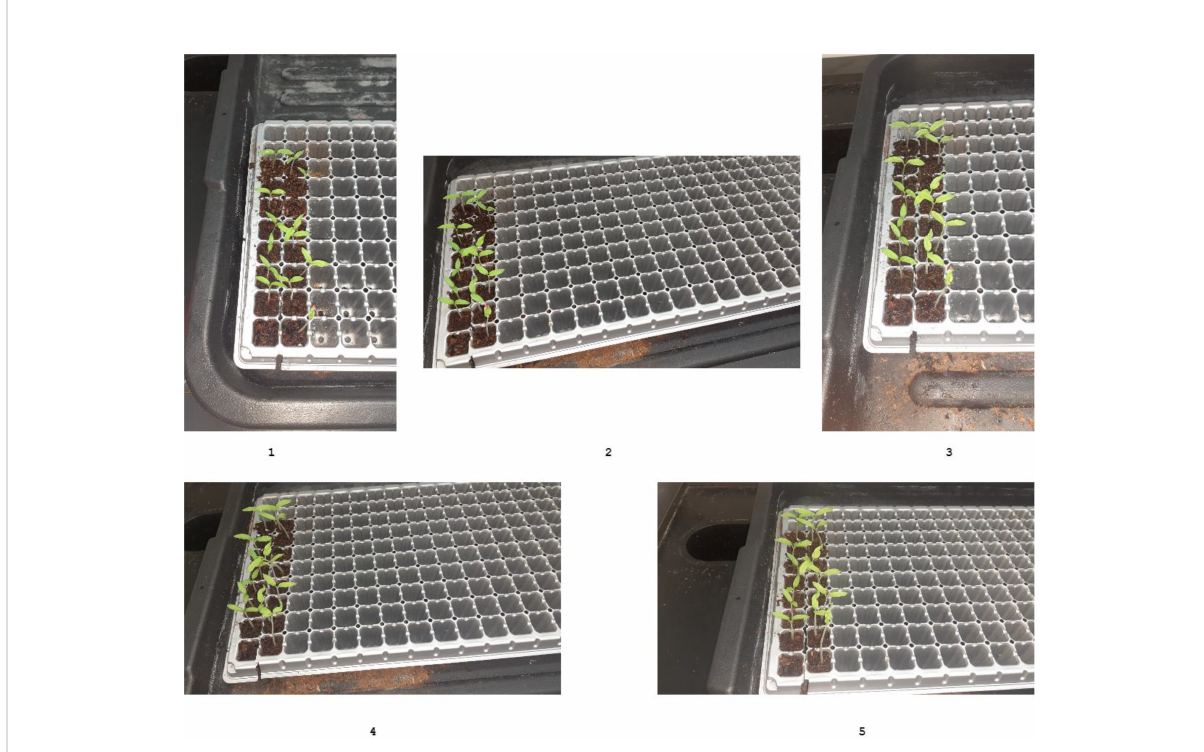
FIGURE 11 Germination stage of our tomato plants (1. 10 th day 2. 11 th day 3. 12 th day 4. 13 th day 5. 14 th